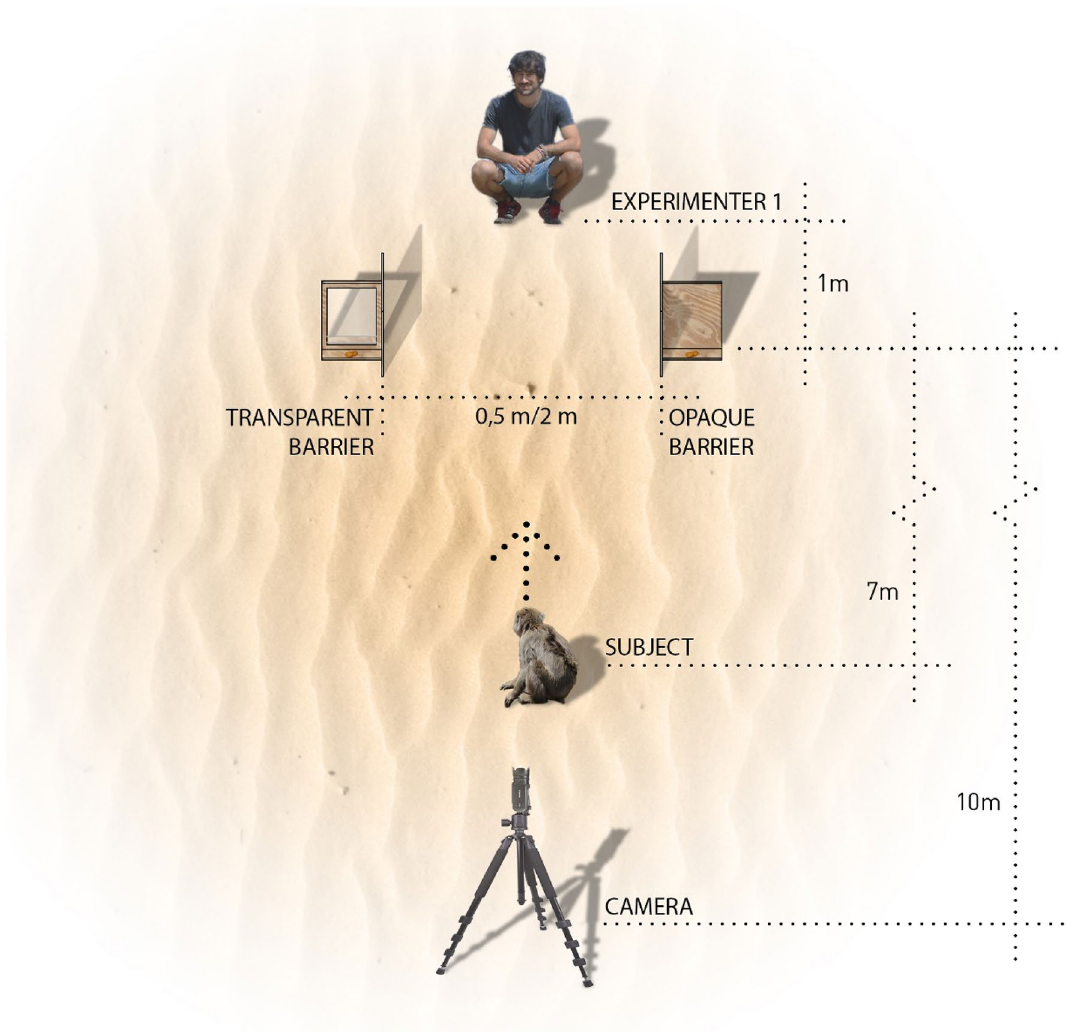
Figure 4. Scheme of the procedure used in the Experimental condition of Experiment 3. The opaque and transparent barriers, with a peanut in front of each one, are located between the experimenter 1 and the subject. The distance between both barriers is 0.5 m in the Session 1 and 2 m in Session 2. A camera on a tripod records the